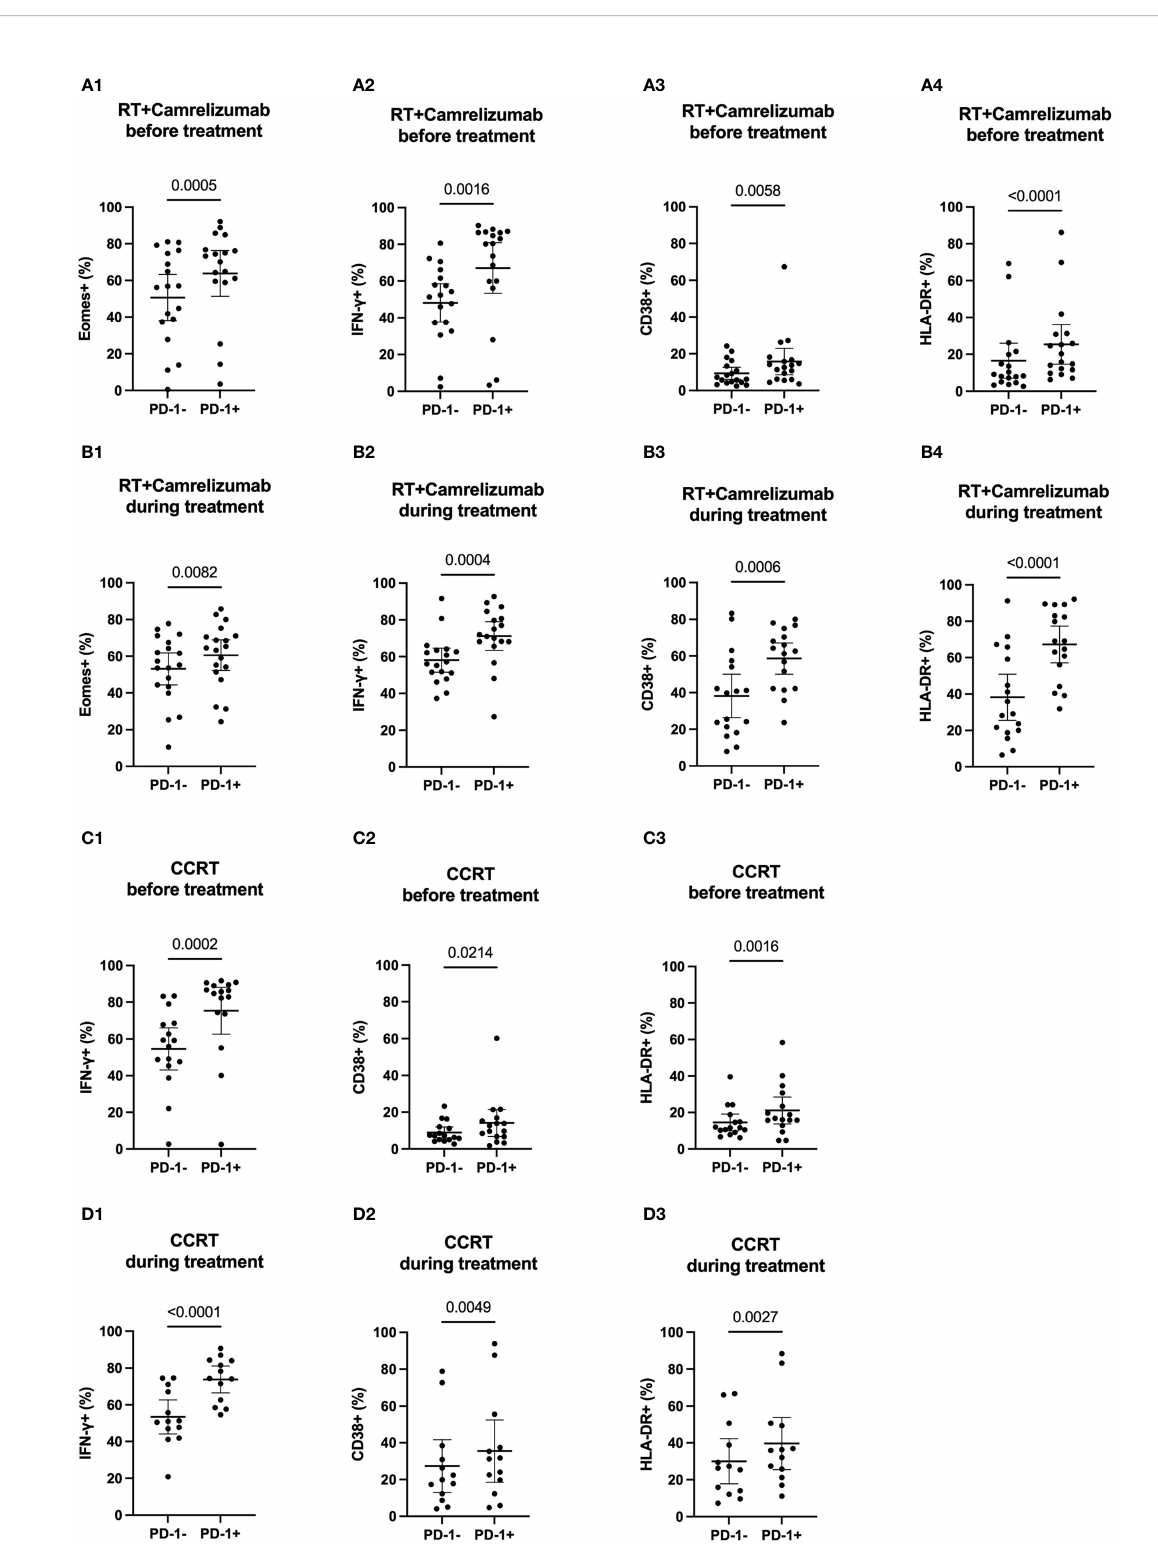
FIGURE 2 The expression levels of molecular markers in PD-1 + and PD-1 - CD8 + T cells. (A) before RT plus immunotherapy treatment. (B) during RT plus immunotherapy treatment. (C) before CCRT treatment. (D) during CCRT